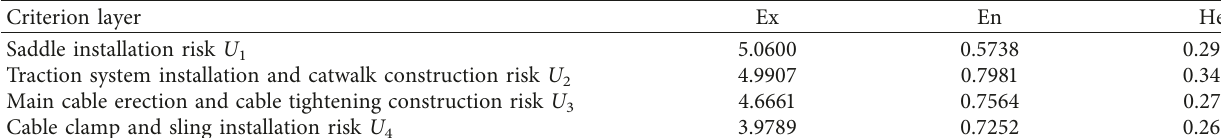
Table 4: Calculation results of the criterion layer attribute cloud characteristic value.